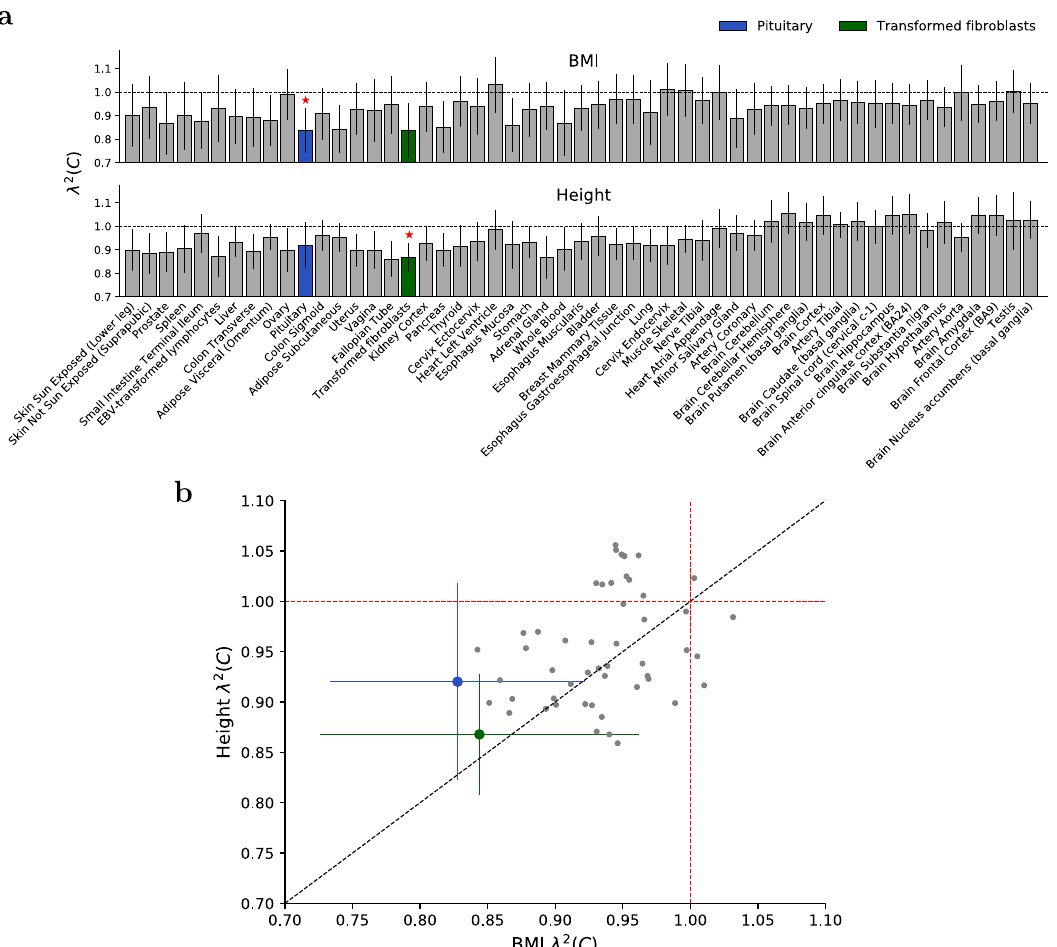
Fig. 5 S-LDXR results for 53 speci fi cally expressed gene (SEG) annotations for BMI and height. a We report estimates of the enrichment/depletion of squared trans-ethnic genetic correlation ( λ 2 ( C )) for each SEG annotation for BMI and height. SEG annotations are ordered as in Fig. 4. Error bars denote ± 1.96 × standard error. P-values are obtained from the standard normal distribution. Red stars ( ⋆ ) denote two-tailed p < 0.05/53 for each respective trait ( p = 8.2 × 10 − 4 for BMI and p = 3.3 × 10 − 4 for Height). b We report λ 2 ( C ) estimates for height vs. BMI for each SEG annotation. These estimates were moderately correlated ( R = 0.35). Annotations are color-coded as in ( a ). For Pituitary, height λ 2 ( C ) is left-shifted by 0.008 and BMI λ 2 ( C ) is right-shifted by 0.008 for easier visualization of standard errors. Error bars denote ± 1.96 × standard error. The dashed black line denotes the y vs x line. Numerical results for all 31 diseases and complex traits are reported in Supplementary Data